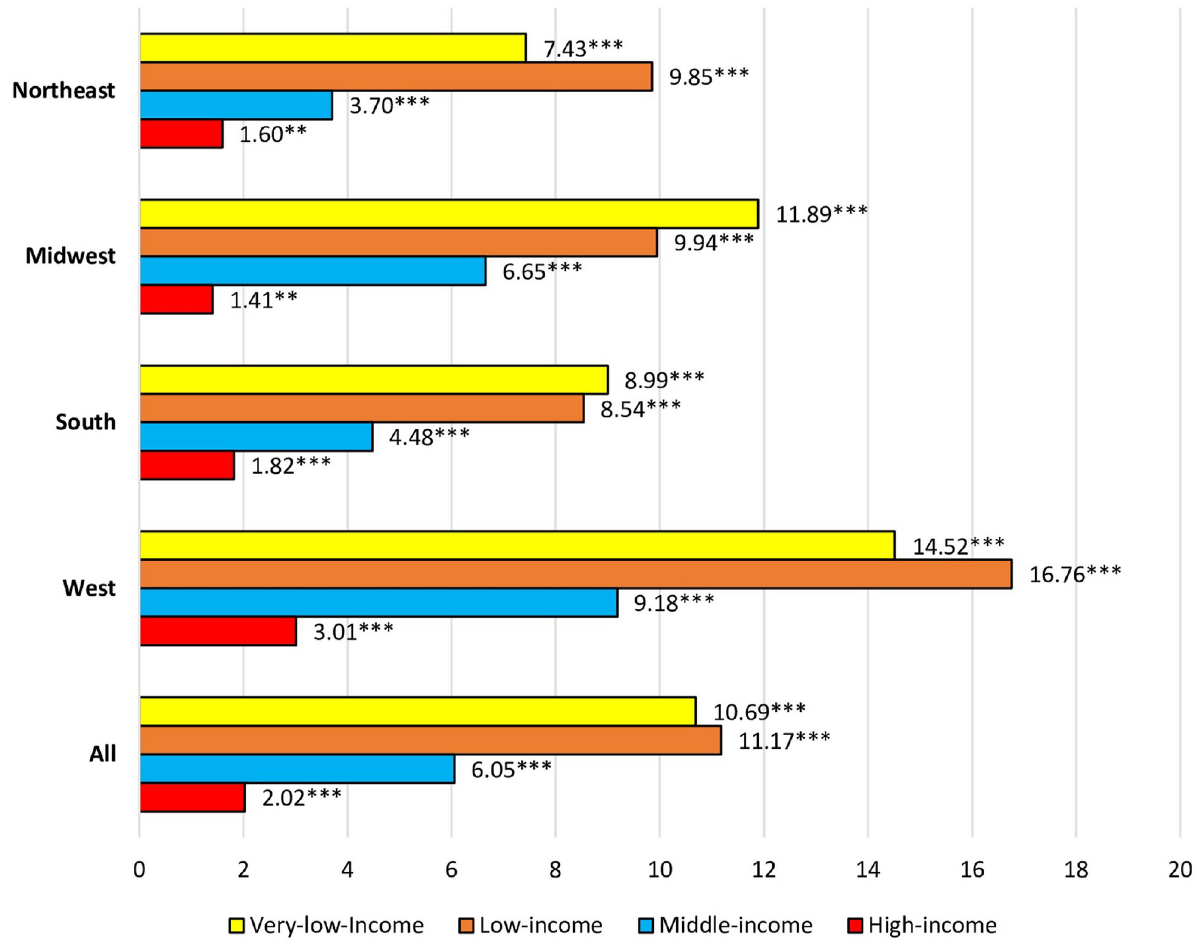
Fig 1. Adjusted percentage point changes in insurance status of individuals ages 18-64 with any Chronic Condition pre-vs. post-ACA by US Census Region and income level, MEPS survey data 2010-2017. Note: � P-value � 0.05, �� p-value � 0.01, and ��� p-value � 0.001.